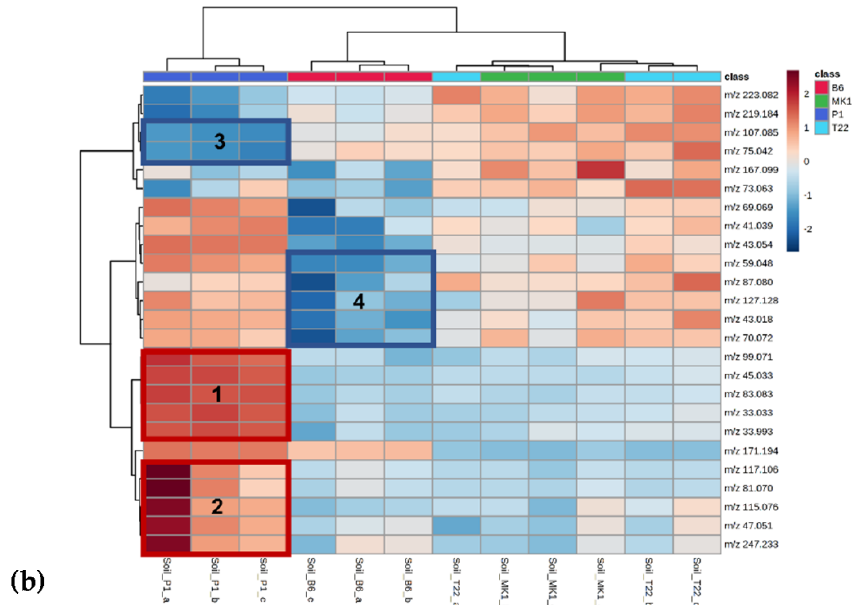
Figure 5. Heat maps and two-dimensional hierarchical dendrograms of VOCs emitted during fungal growth on PDA ( a ) and soil ( b ). Replicates are in columns and variables are in rows. Each coloured cell on the map corresponds with a concentration value following a blue/red chromatic scale from − 2 value (very low expression) to 2 (extremely high expression). Numbered boxes represent well-defined VOC clusters characteristically over (red)- or under (blue)- emitted. Only ANOVA-significant peaks are used ( p < 0.05). The Pearson distance and Ward’s clustering algorithm were used for the dendrograms. The probable identification and chemical group of the VOCs are detailed in Table S2.